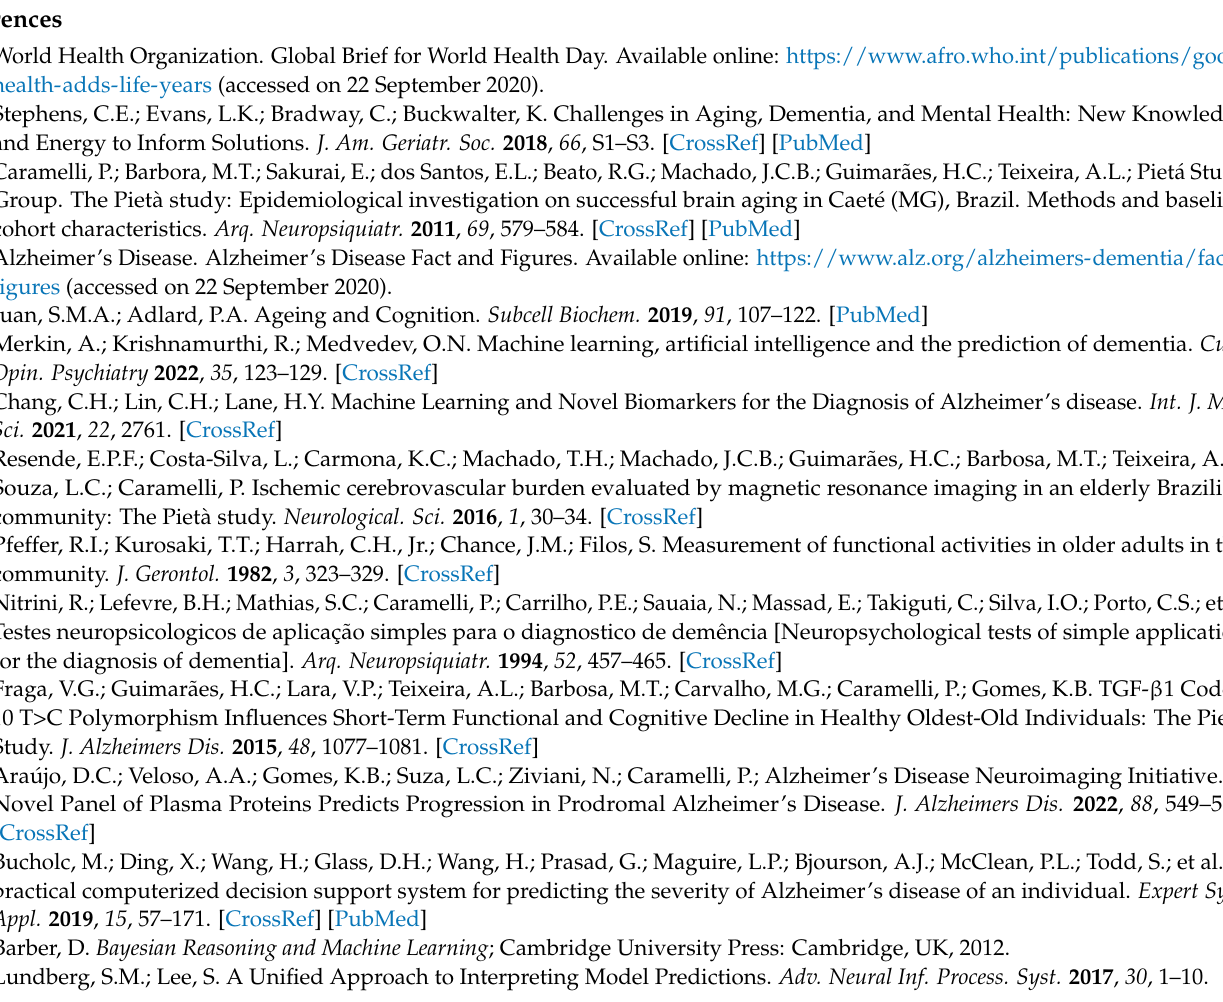
algorithm. Table S2: Routine laboratory variables measured at baseline in cognitive/functional decliners and non-decliners. Table S3: Performance of Machine Learning models applied in the